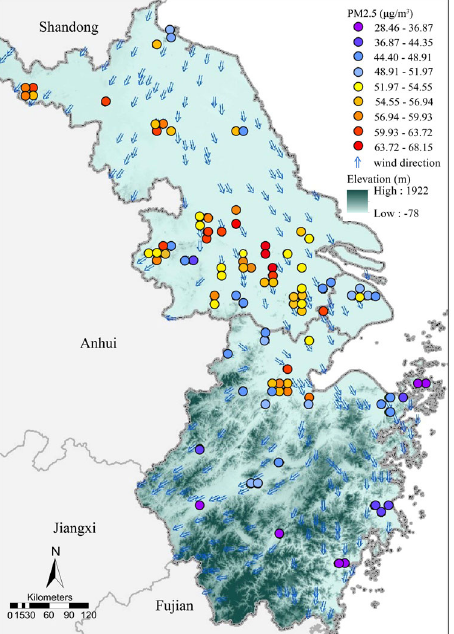
Figure 1. Study area, PM 2.5 monitoring stations, and the wind fields with their annual mean values. Annual averages are calculated from PM 2.5 monitoring values and wind field data for the period March 2015 to February 2016, which are provided by the China Environmental Monitoring Station and European Centre for Medium ‐ Range Weather Forecasts, respectively.